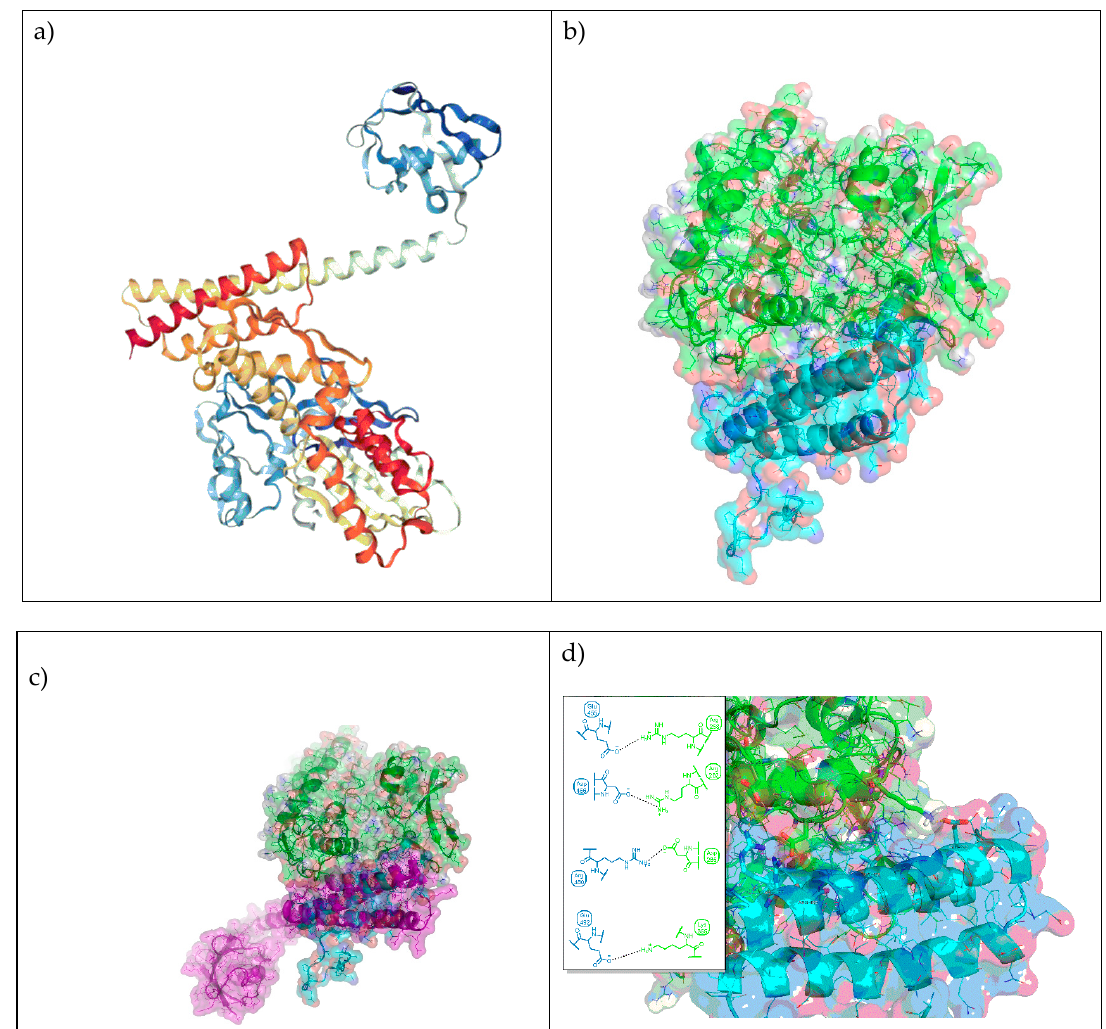
Figure 1 . Modelled interaction of BAG3 with HSP70. ( a ) Crystal structure of the homologue BAG1 binding to HSP70 (PDB 4HWI). ( b ) Homology model of BAG3 (cyan) binding to HSP70 (green). ( c ) Superimposition of BAG1 (magenta) and BAG3 (cyan) in complex with HSP70 (green). ( d ) Two-dimensional and three-dimensional depiction of plausible key interactions observed by visual inspection of the modelled interaction, BAG3 residues are coloured in light blue and HSP70 residues in green.